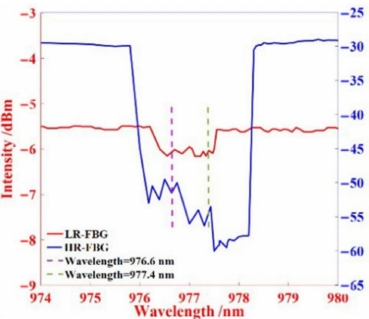
Figure 9. The transmission spectra of HR-FBG and LR-FBG.